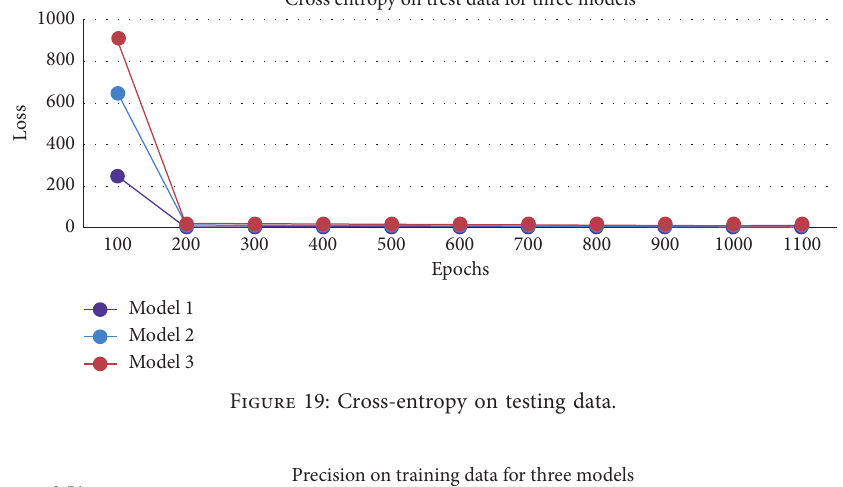
Figure 19: Cross-entropy on testing data.